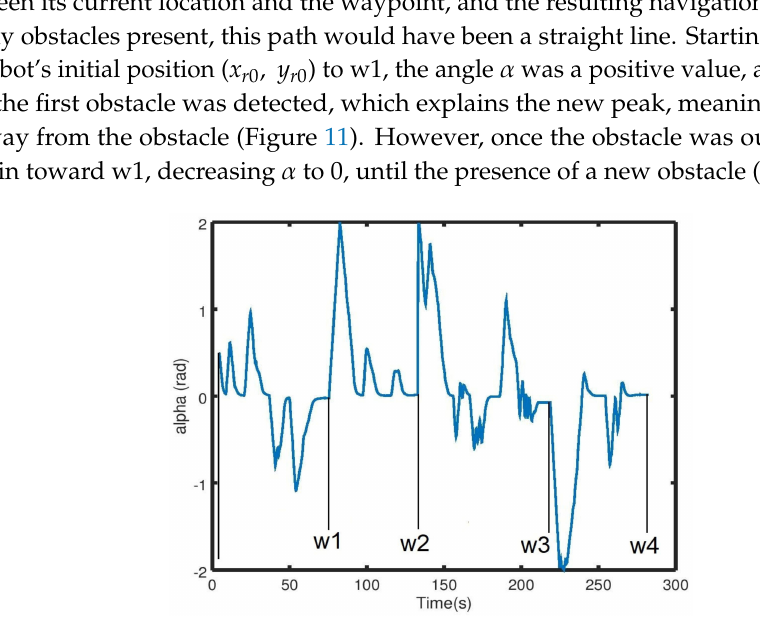
Figure 10. The variation over time of the distance between the robot’s position and the given waypoints. As for the angle α , the variation over time could be divided into four slots: (( x r 0 , y r 0 ) to w1, w1 to w2, w2 to w3, w3 to w4 (Figure 11), where each slot was the time the robot needed to reach a given waypoint. The angle variations within the slots were a result of obstacles located along the path of the robot between its current location and the waypoint, and the resulting navigation to get around them.